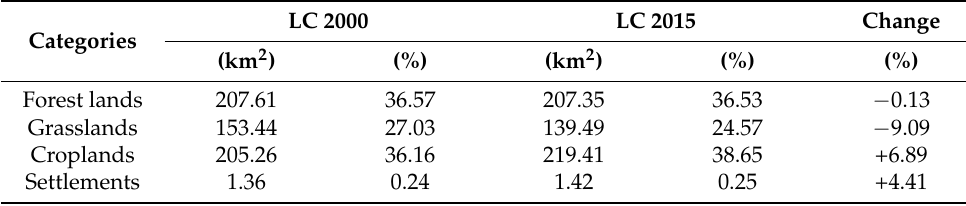
Table 2. Changes in Land Cover (LC) categories from 2000 to 2015 in Ixtacamaxtitlan.